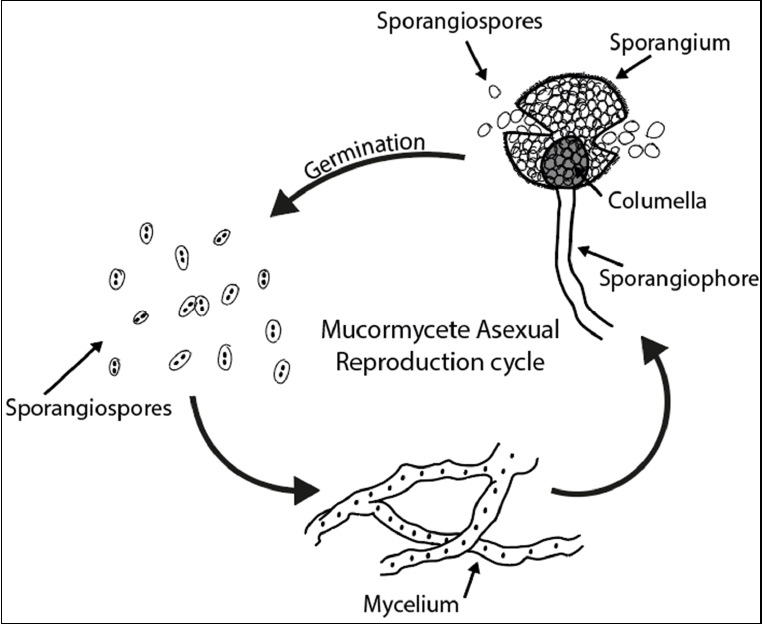
Figure 3. Generalised mucormycetes’ asexual reproduction cycle (adapted after Bell [16]). Sporan- giospores are the spores produced inside the sporangium which is a cell of a fungus which contains spores. The sporangiophore is the stalk of the sporangium and the columella is a column of sterile tissue which bears spores. Heterothallic Mucormycetes species have two sexual hyphae, which grow together [43]. The hyphae apex is fused through the formation of progametangia once trisporic acid, a pheromone compound, is produced [43]. Subsequently, the progametangia become the gametangia when the apex fuse; this is followed by the septum separating the apex [43]. After the septum disintegrates, the nuclei in the cell are fused creating the prozygo- sporangium, which enlarges into zygosporangia [43]. These then form hyphae, and after germination, produce germ sporangia [43]. Germ sporangia often contain both mating types of sporangiospores [43], thus completing the negative feedback loop (Figure 4). The sporangiospores are then ejected through various mechanisms that are dependent on the species and the environment [16,26], but are likely dispersed through the air [42].